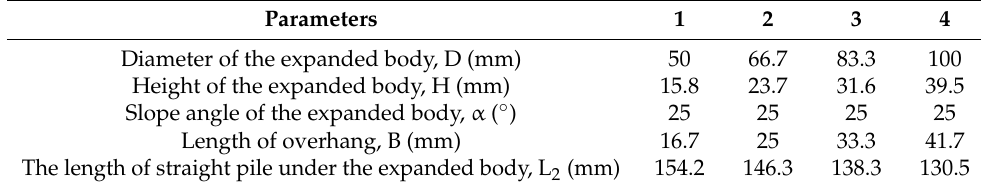
Table 2. The parameters of the model